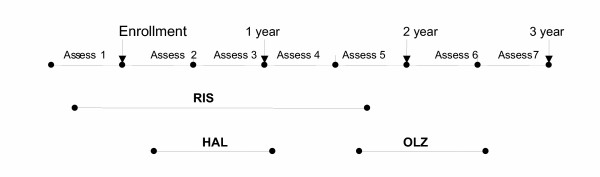
Treatment-episodes approach. Abbreviations: RIS, risperidone; OLZ, olanzapine; HAL, haloperidol. Using the treatment episode approach, a patient may have initiated several treatment episodes over the course of this 3-year study. This figure shows an example of the treatment pattern of a patient with 3 treatment episodes. Patients were administered study measures at the end of each 6-month assessment period.